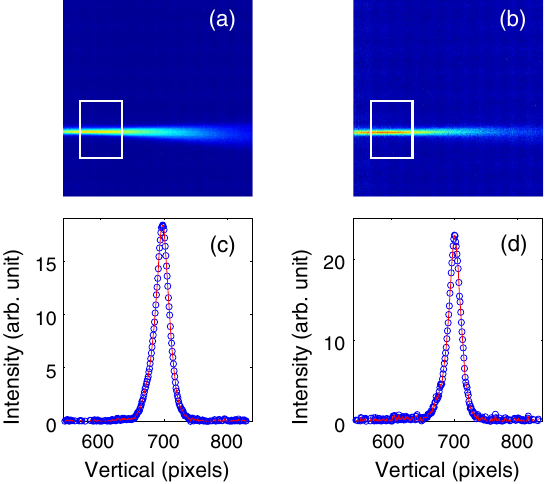
FIG. 9. OTR images of horizontal stripes (a) total OTR and (b) horizontally polarized OTR. The projected y profiles from the region of interest are shown below each image, (c) and (d) respectively.